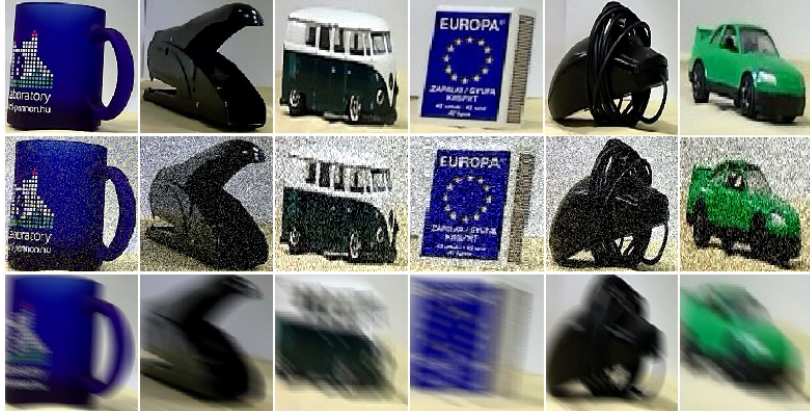
Figure 3. Test image examples from SUP-16 without noise ( first line), with additive Gaussian noise ( middle line), and with strong motion blur ( bottom